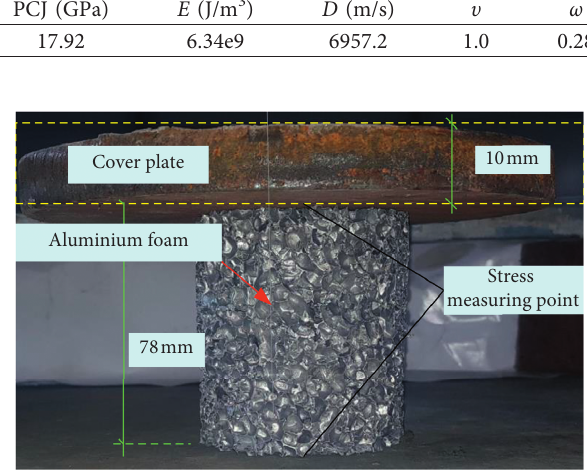
Figure 5: Sandwich plate antiexplosion test device.